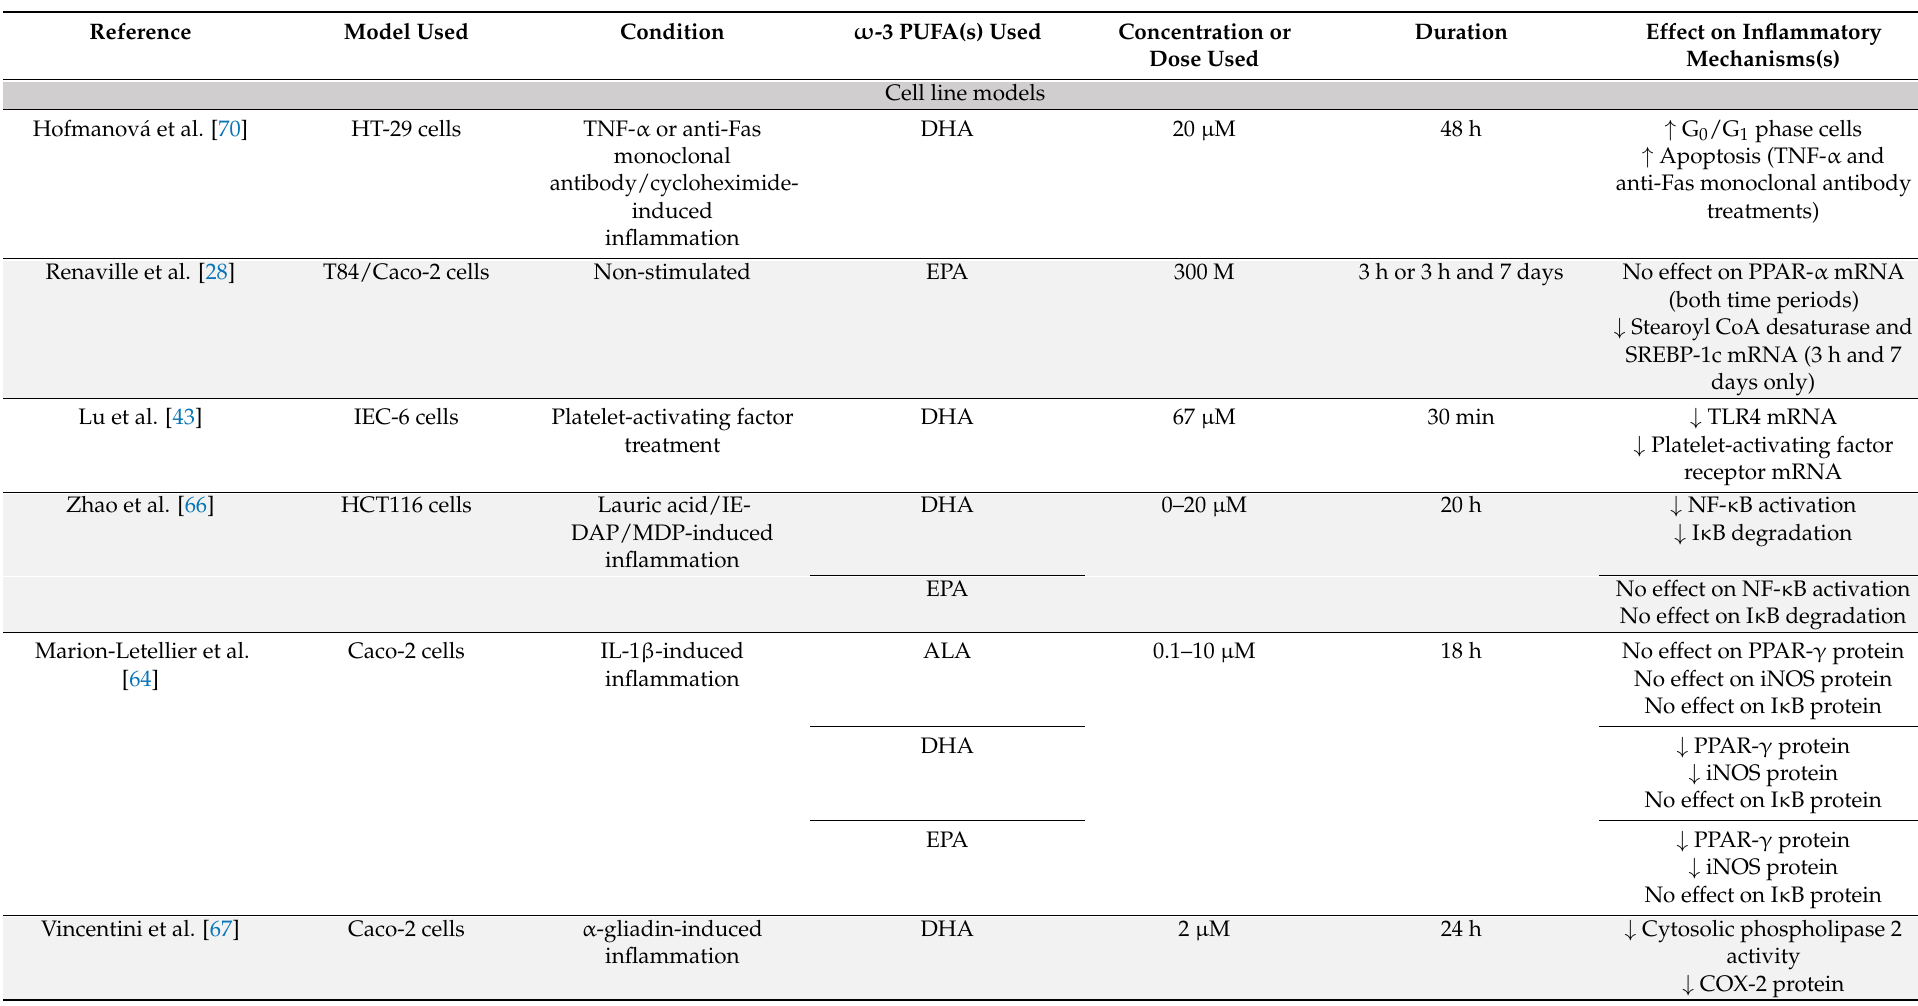
Table 6. Effects of ω -3 PUFAs on inflammatory mechanisms in rodent and cell